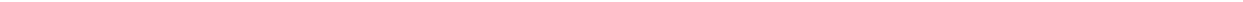
Fig. 1 Improved glycemic control in diabetic mice transplanted with Y1 receptor-de fi cient islets. a Photomicrograph showing immune fl uorescence staining for insulin ( green ), PYY ( red ) and DAPI ( blue ) in islets from human, wild type, and PYY knockout mice. Scale bar , 25 μ m. b Y1 receptor mRNA expression in pancreatic islets isolated from lean or obese mice determined by qRT-PCR ( n = 4). c Pancreatic islets from C57BL/6JAusb mice were isolated and cultured. Insulin secretion was determined in response to 2 and 11 mM glucose in the presence of PYY and/or Y1 receptor antagonist BIBO3304 ( n = 3). d Perifusion experiment to record insulin release over a 50 min period using islets from C57BL/6JAusb mice stimulated with 11 mM glucose and treated with PYY or Y1 antagonist BIBO3304. ( n = 4 – 5). e Results expressed as area under the curve. f Alloxan-induced diabetic mice were transplanted with an optimal number (300) of WT islets ( n = 8) or a minimal number (60) from WT islets ( n = 15) or Y1 − / − islets ( n = 13) and blood glucose levels were monitored for 20 days. g Results expressed as area under the curve. h – k Diabetic mice receiving 60 WT ( n = 4) or Y1 − / − ( n = 4) islets were fasted overnight and i.v. glucose tolerance tests (1 g/kg body weight) were performed at day 5 post-transplant. Blood glucose levels and insulin production during glucose tolerance tests were monitored. Results are expressed over the time course and as area under the curve. l , m 7-week-old C57BL/6JAusb mice were treated with placebo ( n = 6) or with 0.5 μ M of the Y1 receptor speci fi c antagonist BIBO3304 ( n = 6), 2 h prior to i.p. glucose injection (1 g/kg body weight) and serum insulin levels in response to glucose administration at indicated time points were determined. Results are also expressed as area under the curve. Data are shown as mean ± s.e.m. * P < 0.05, ** P < 0.01, calculated by t -test ( b , c ) or two-way ANOVA